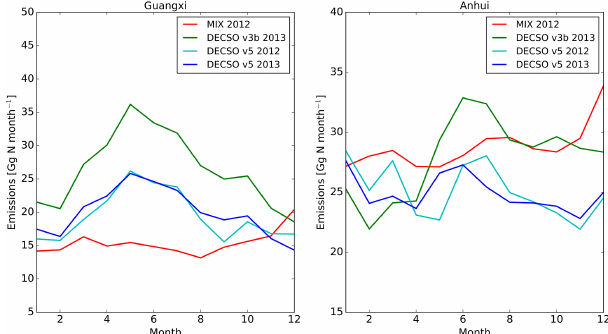
Figure 6. Monthly total emissions estimated by DECSO v5 (blue line) and DECSO v3b (green line) of Guangxi province (left) and Anhui province (right) in 2013. The cyan line and the red line rep- resent monthly NO x emissions from DECSO v5 and the MIX in- ventory in